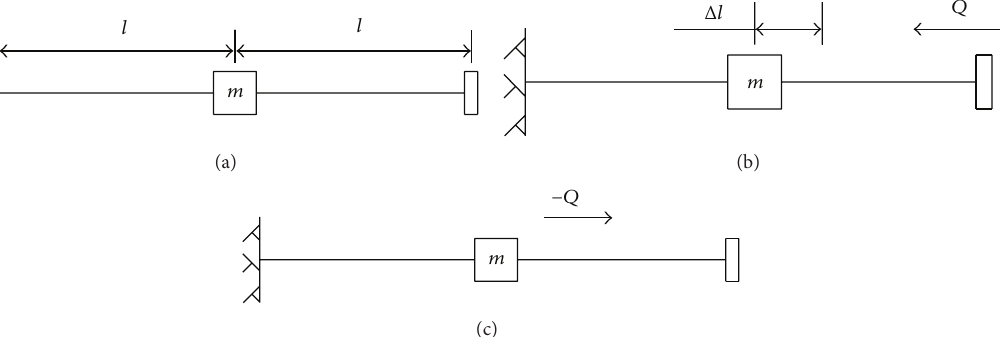
Figure 2: Operation chart of negative stiffness process.